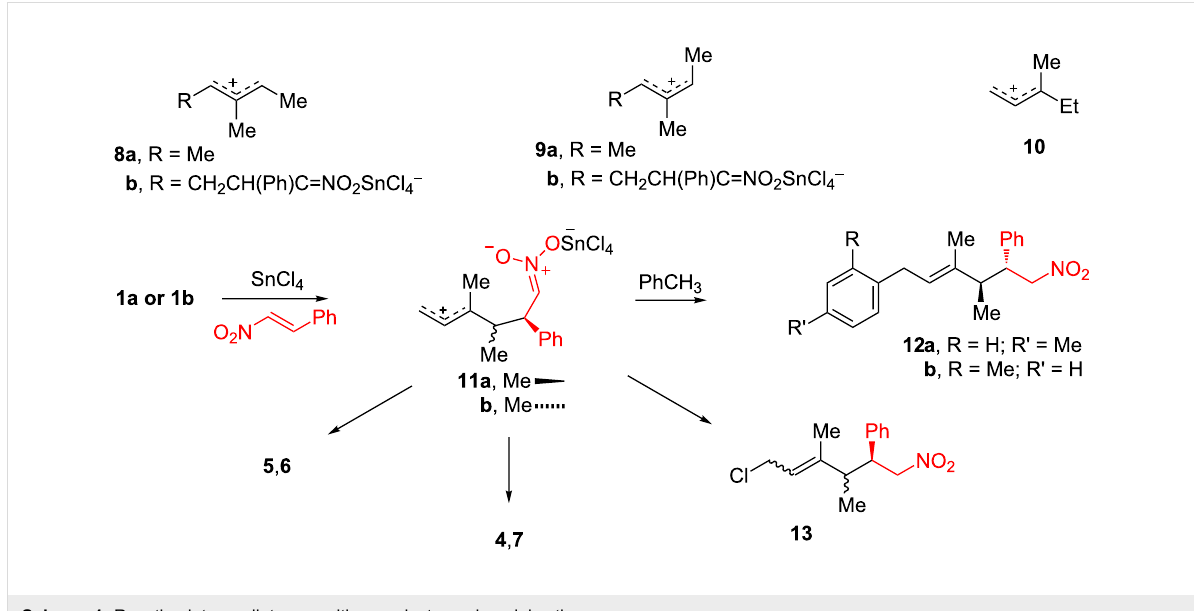
Scheme 1: Reaction intermediates, resulting products, and model